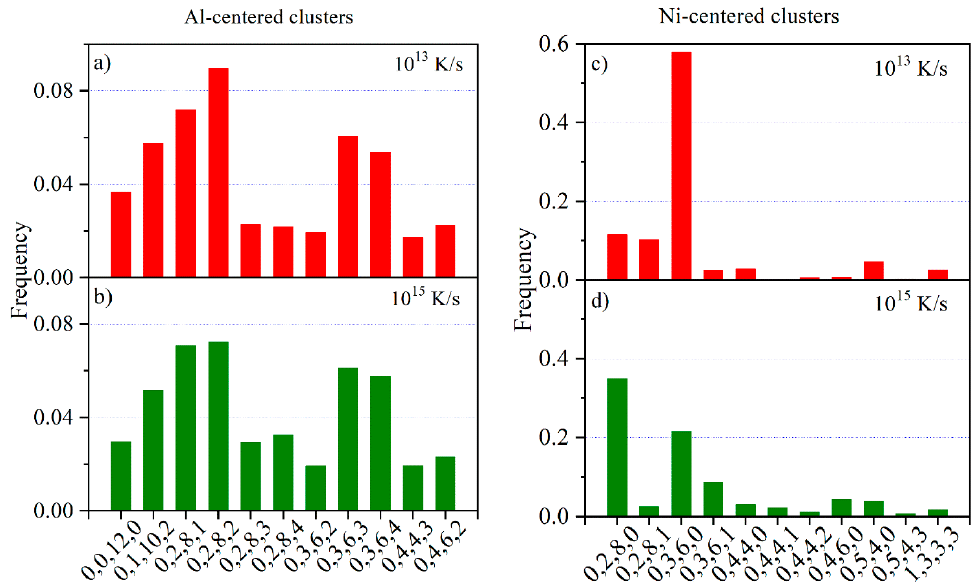
Figure 4. Distribution of Al- and Ni-centered clusters in Al 86 Ni 9 La 5 glasses with two cooling rates of 10 15 K/s and 10 13 K/s: ( a ) 10 13 K/s, Al-centered clusters; ( b ) 10 15 K/s, Al-centered clusters; ( c ) 10 13 K/s, Ni-centered clusters; ( d ) 10 15 K/s, Ni-centered clusters.